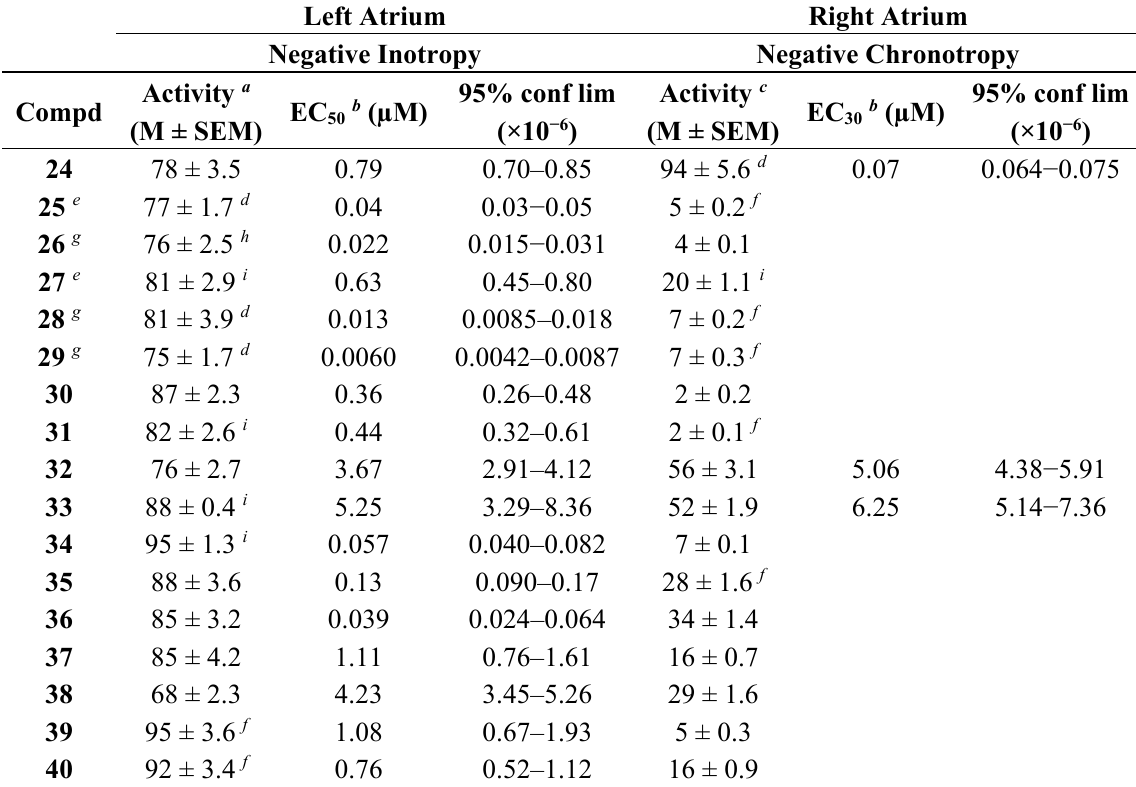
Table 1. Cardiac activity of compounds 24 – 40 .